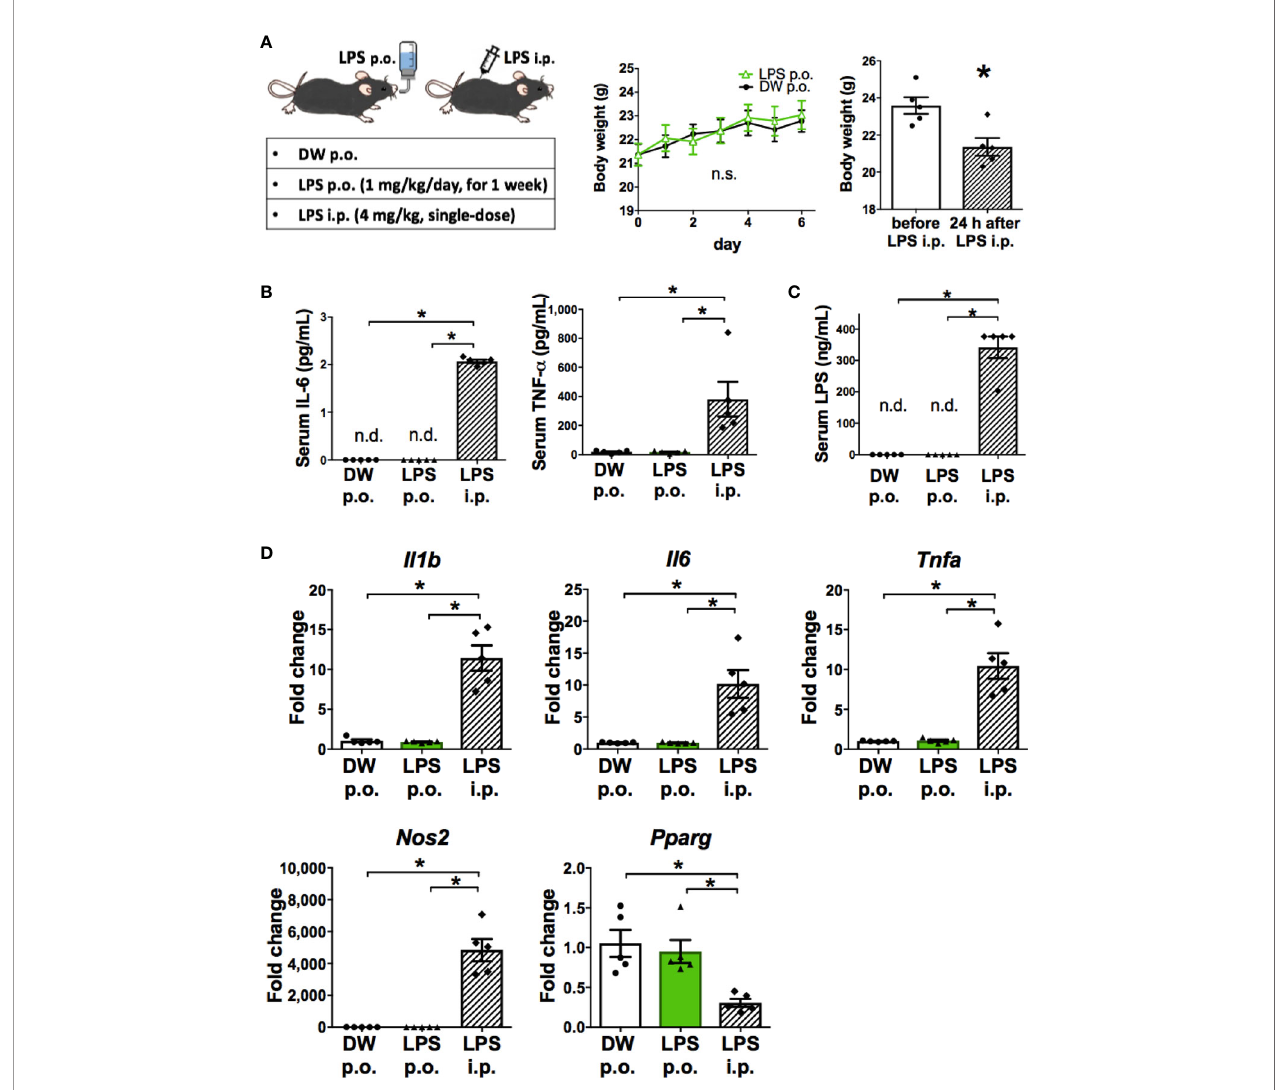
FIGURE 2 | OAL-microglia are distinct from in fl ammatory microglia transformed by intraperitoneal injection of LPS. (A) No weight loss by OAL in naïve mice without STZ i.c.v. (n = 5). (B) No increase in serum in fl ammatory cytokines by OAL. (C) Undetectable serum LPS by OAL. (D) OAL-microglia showed distinct gene expression patterns from in fl ammatory microglia transformed by LPS i.p. Means ± SE are presented. *p < 0.05 for Student ’ s t test, one-way ANOVA with Tukey ’ s multiple comparisons, or two-way ANOVA with Sidak multiple comparisons. n.s., not signi fi cant; n.d., not detected; i.p.,